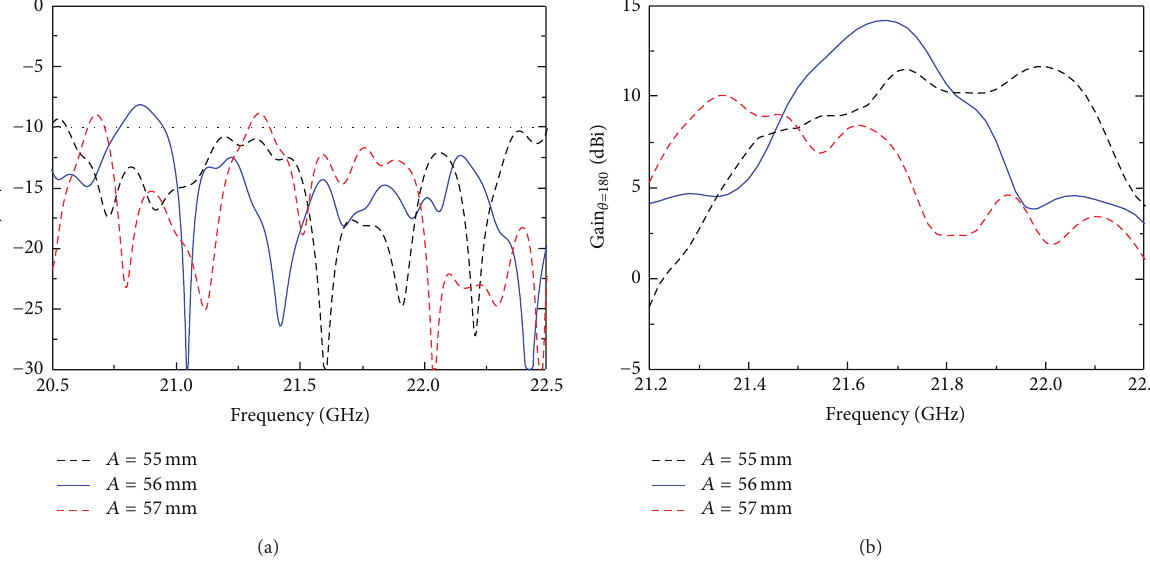
Figure 5: Effect of the cavity length, or substrate lateral size, 𝐴 , on antenna characteristics with respect to (a) the reflection coefficient and (b) boresight